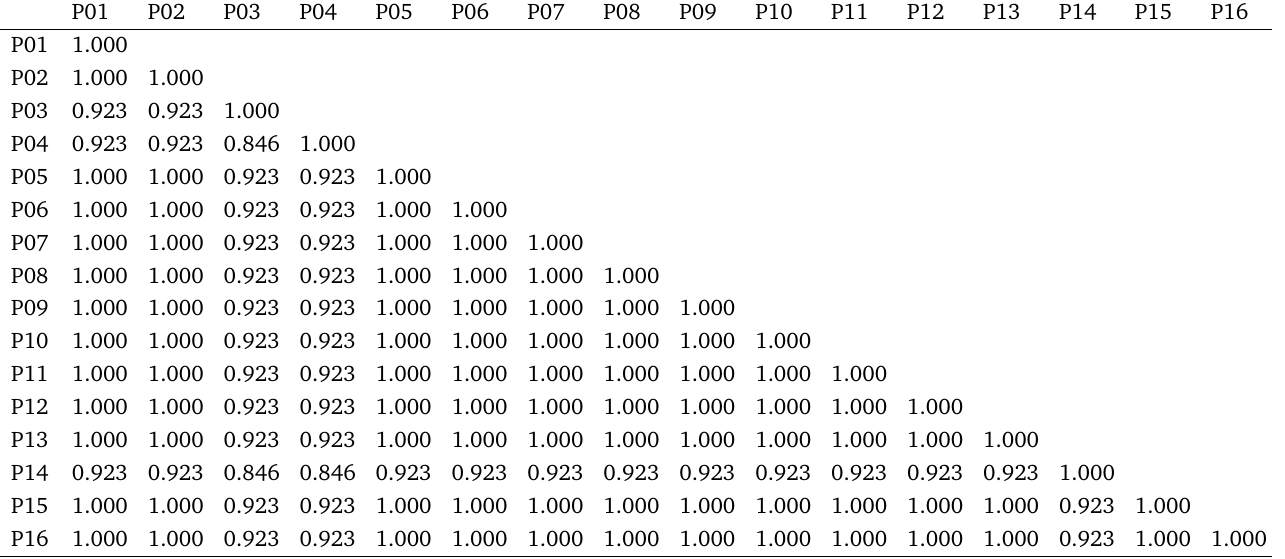
Table 4. Jaccard’s similarity coefficients of seed total protein profiles of Parkia biglobosa accessions.